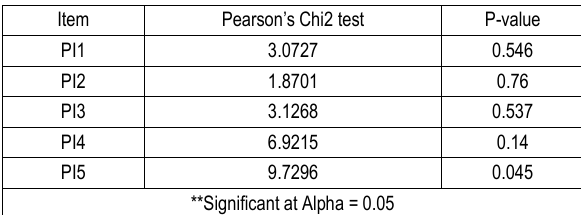
Table 9. Association between gender and purchase